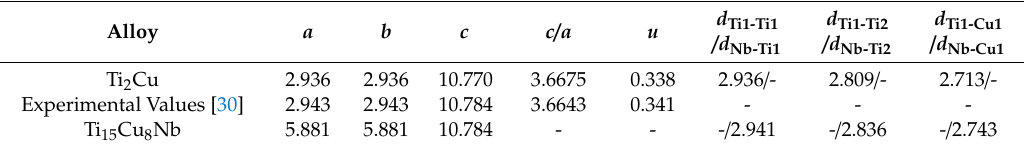
Figure 1. Crystal structures of Ti 2 Cu ( a ) and Ti 15 Cu 8 Nb ( b ). Table 1. Calculate the structural parameters a(Å), b(Å), c(Å), c / a, u , and interatomic distances d (Å) for Ti 2 Cu and Ti 15 Cu 8 Nb with the experimental data from [30].